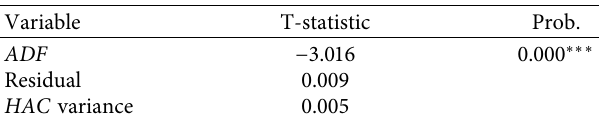
Table 8: The results of Kao test.